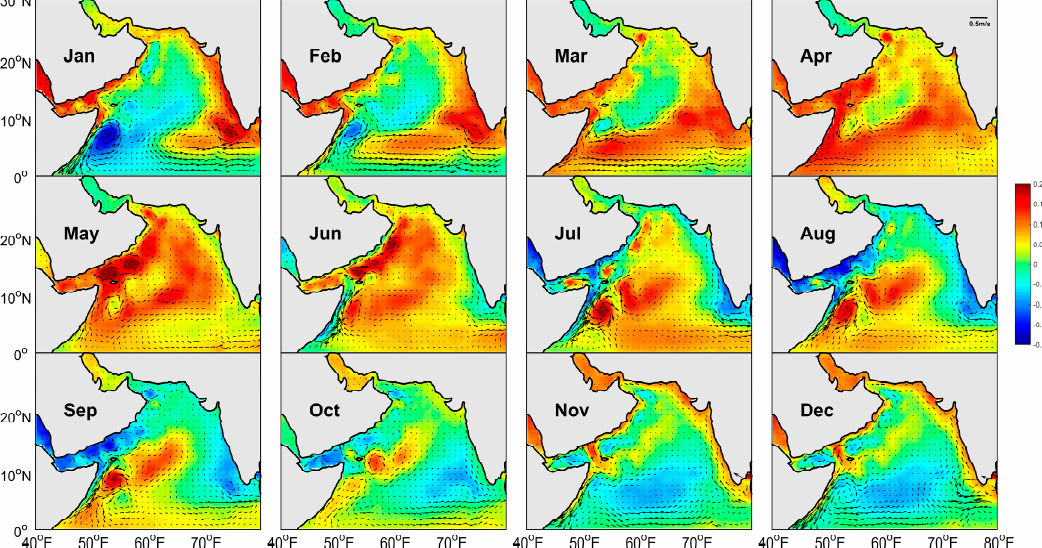
Figure 3. Monthly mean SLA and sea surface flow averaged from 1993 to 2015 (the vectors are the sea surface geostrophic currents, unit: m · s − 1 , background color is SLA, unit: m).